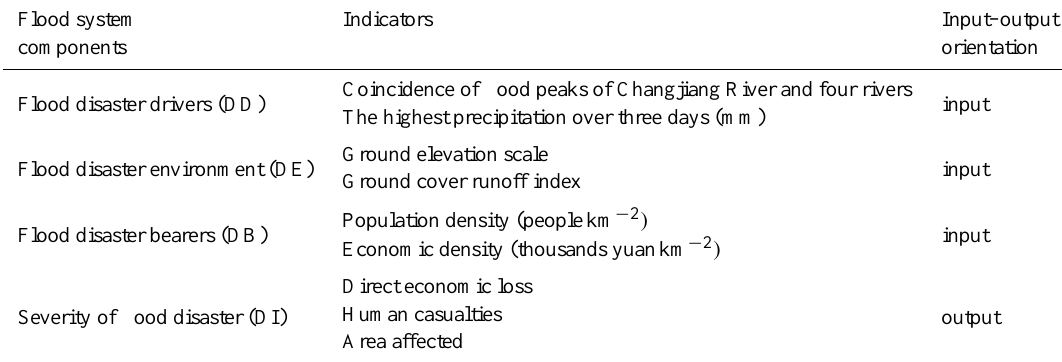
Table 2. The selection and processing of indicator systems used for vulnerability assessment.